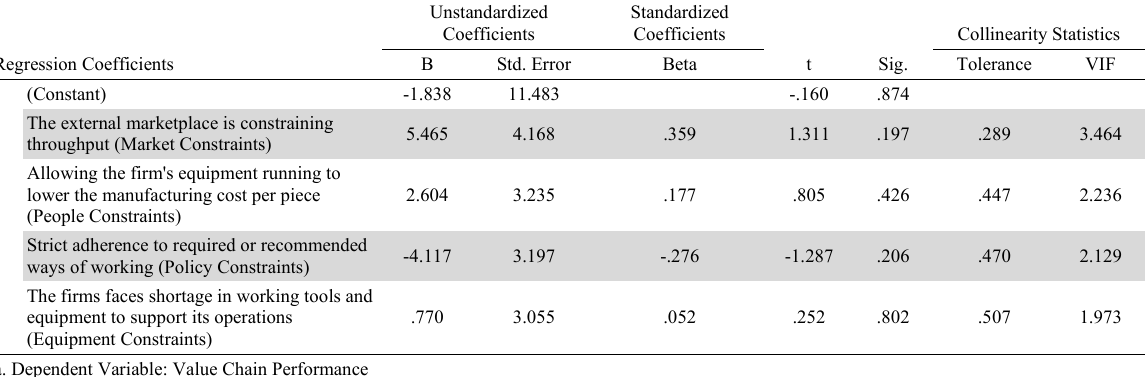
Regression Coefficients for the Relationship between Constraints Management and Value Chain